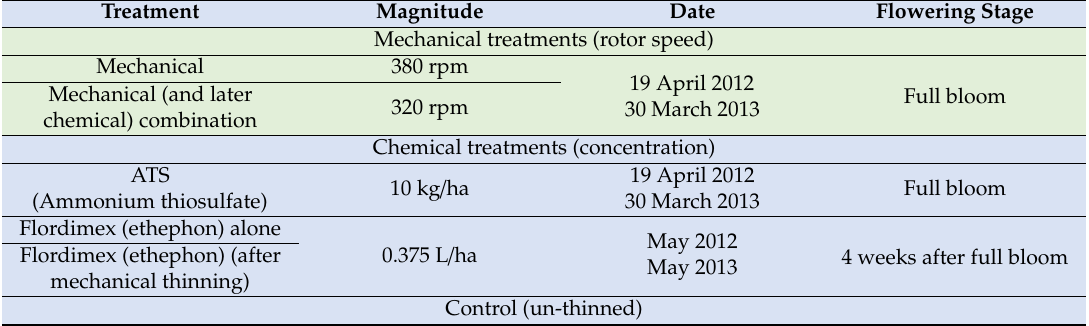
Table 1. Mechanical (green) and chemical (blue) thinning treatments on European plums in 2012 and 2013. Magnitude Date Flowering